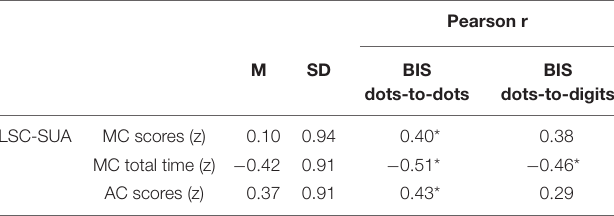
TABLE 1 | Descriptive statistics of scores in the two calculation subtests from LSC-SUA and correlation with balanced integration scores (BIS) from match-to-sample